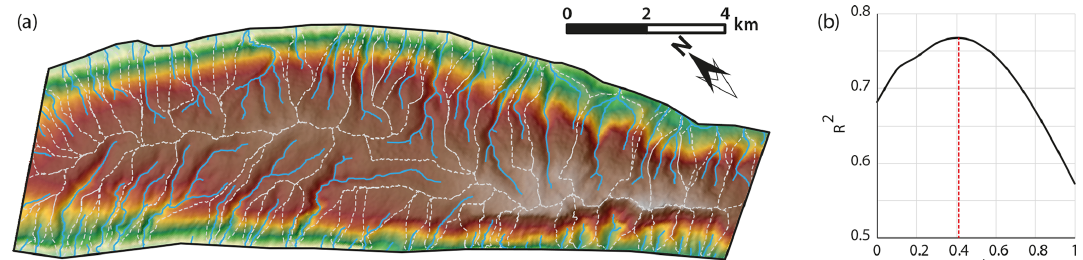
Figure 5. (a) DEM grid, drainage network, and basins for the present-day Harir Anticline that is used as an input for the model. White lines are basin divides; (b) m/n plotted against regression values of elevation–X plot for streams in the Harir Anticline. The highest regression is achieved for m/n = 0 . 41.